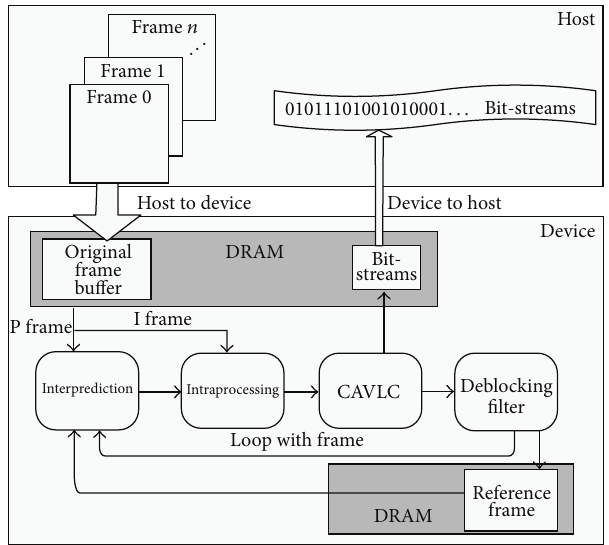
Figure 3: The proposed H.264 encoder